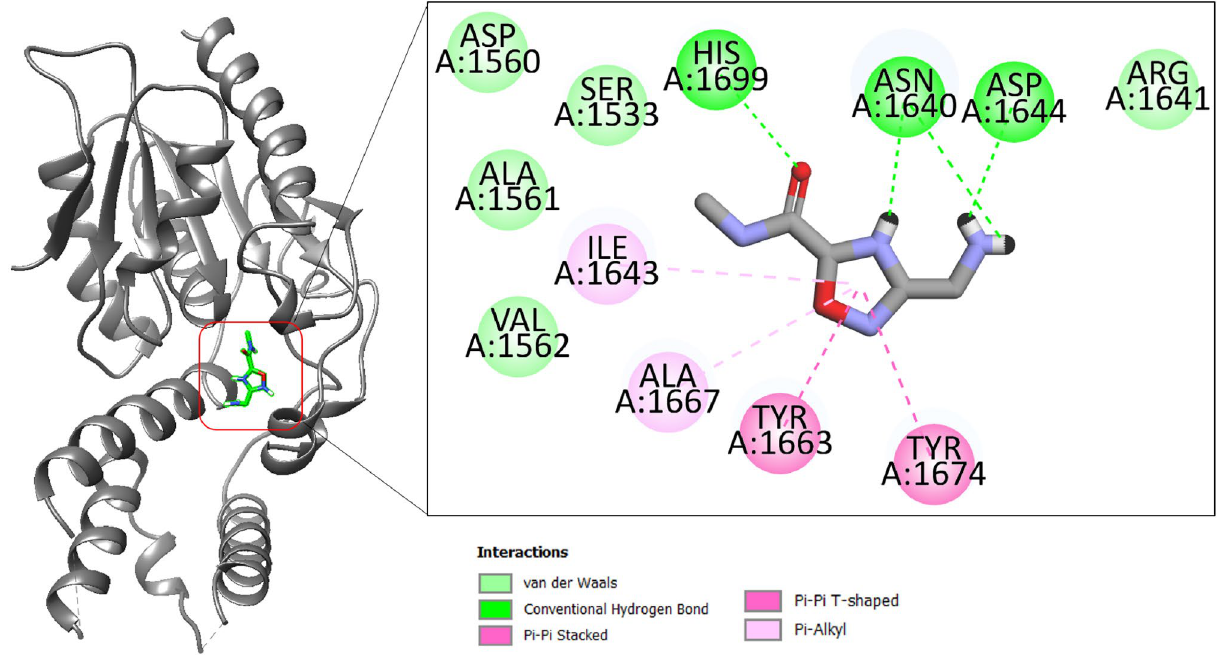
Figure 3. Binding mode of compound BBC_29956160 at the active pocket of polyketide synthase Pks13. The receptor enzyme is given in gray cartoon while the compound is presented in green stick. The binding interactions network is also provided.